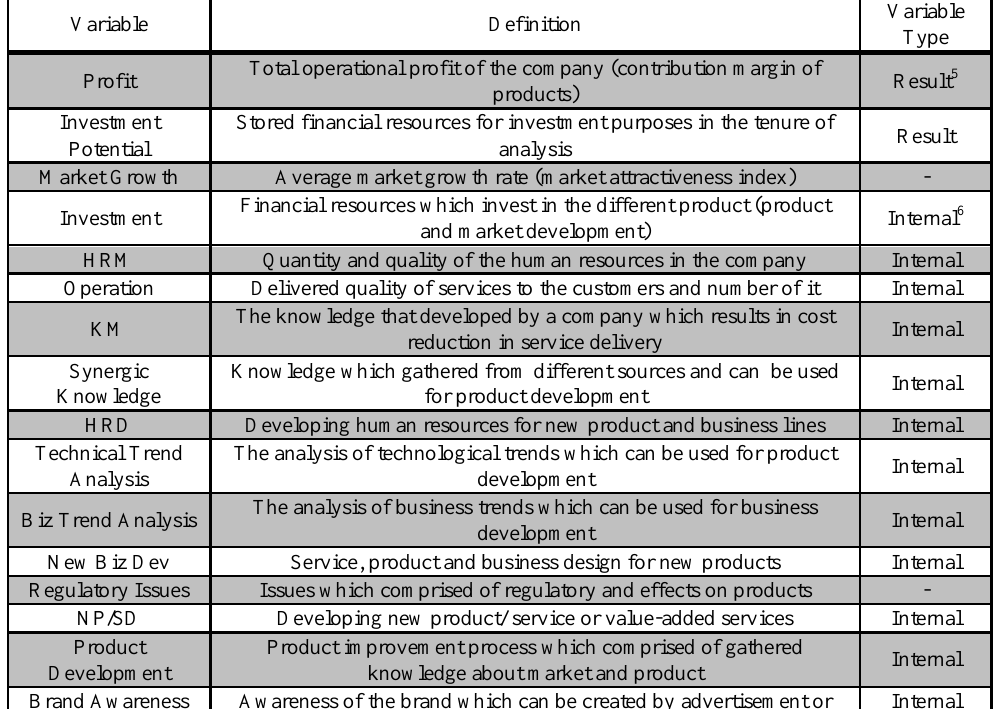
Table 3. CLD for PPM model in the financial technology industry of